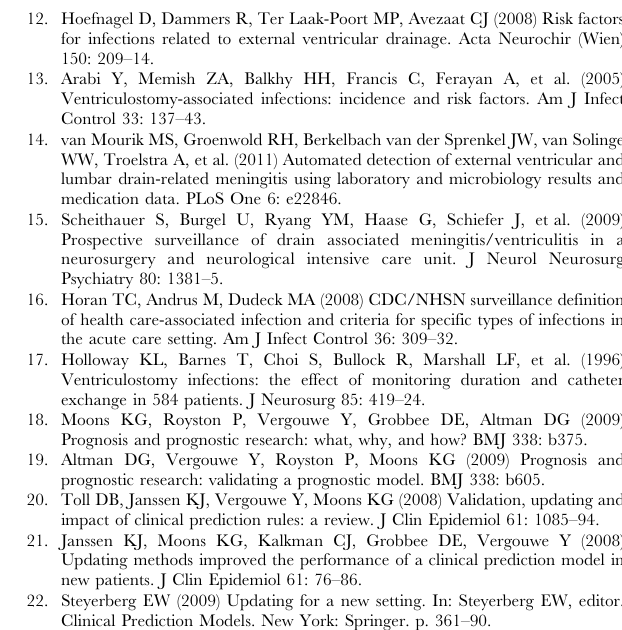
Table S1 Comparison of patients with and without missing